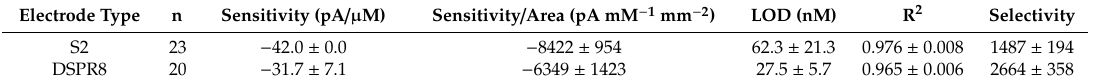
Table 1. Recording properties of microelectrode arrays for the measurement of